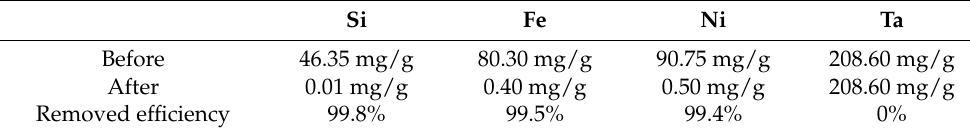
Table 3. Removed efficiency of silicon, iron, and nickel after the pretreatment.